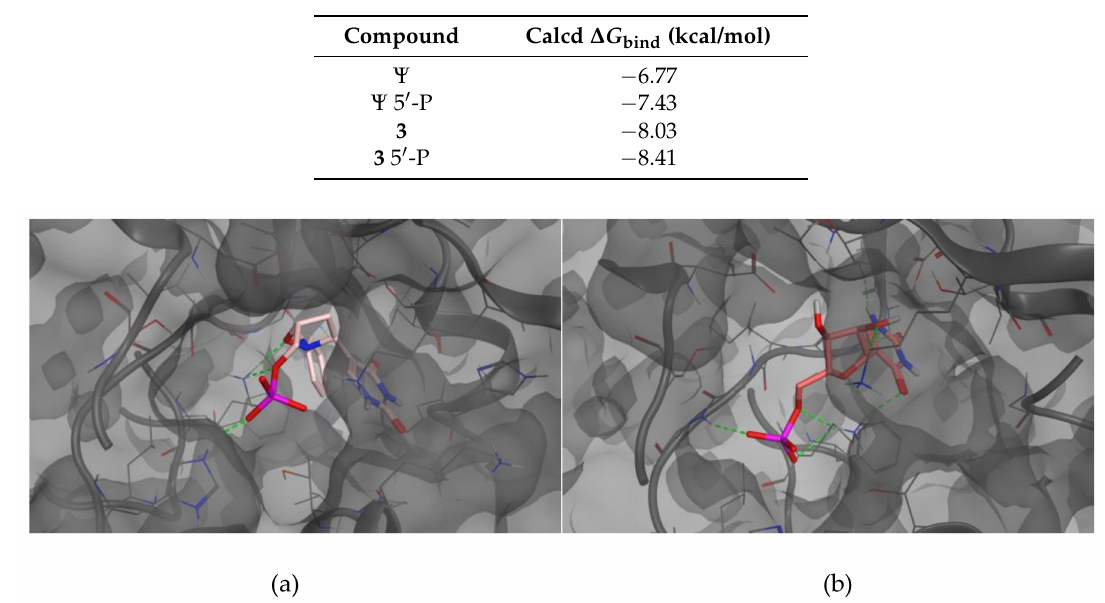
Table 1. Calculated binding energies ( ∆ G bind ) inside the catalytic site of the Ψ 5 (cid:48) -P Gly for all studied compounds.